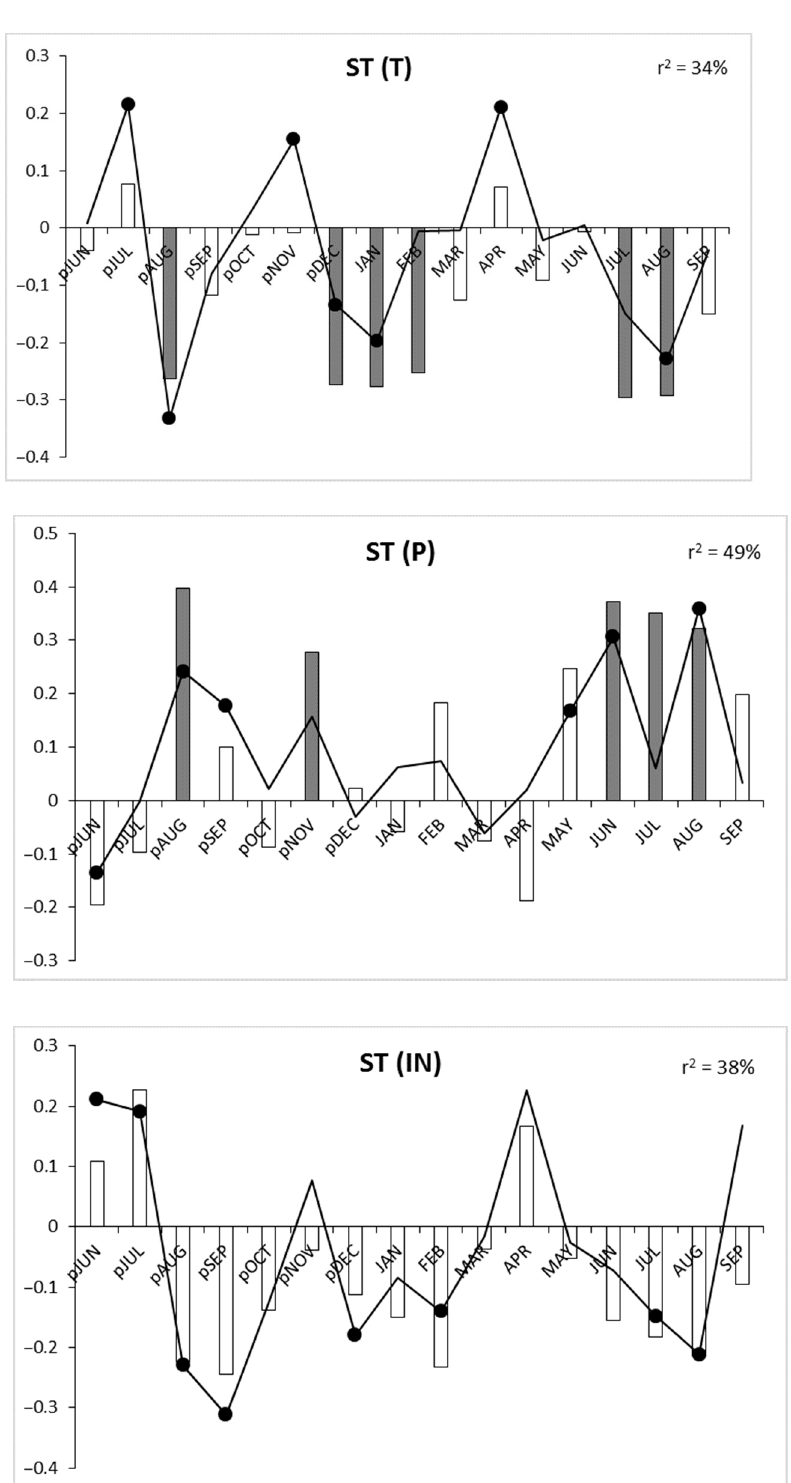
Figure 4. Response function analysis for air temperature—T, precipitation—P and insolation—IN. Bars depict correlation coefficients, lines show regression coefficients, significant values ( p ≤ 0.05) are indicated by gray bars and solid black dots, p—previous year, r 2 —multiple regression determination coefficients.